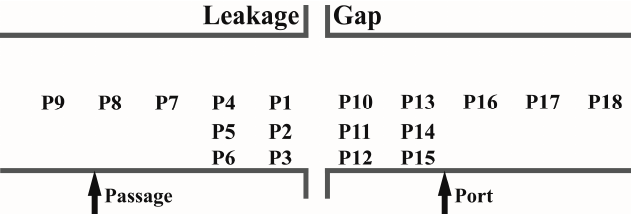
Figure 12. Verification model of the leakage-attributed shock wave losses.